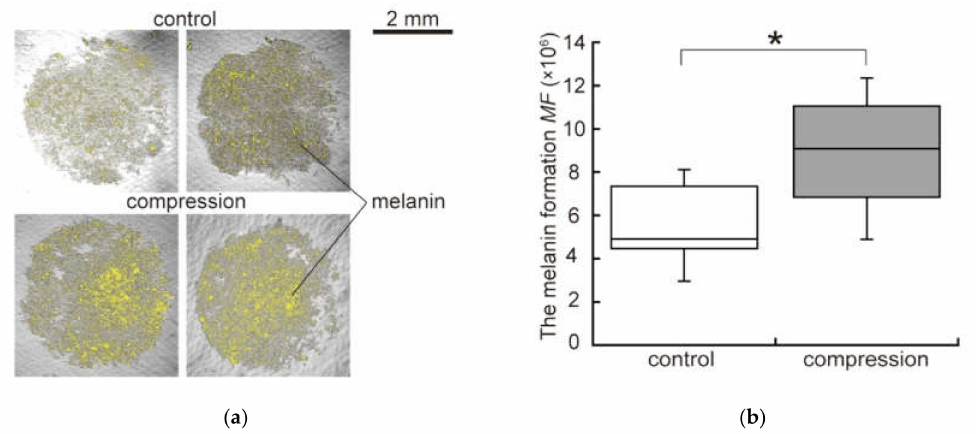
Figure 5. The di ff erence of melanin synthesis in the malignant melanoma model: ( a ) Distribution of synthesized melanin in both groups at 32 h of culture. Yellow color in the images indicates the concentrated melanin; ( b ) The melanin formation ( MF ) at 32 h (n = 5). Experimental data were examined for significant di ff erences using Student’s t -tests. * indicates a significant di ff erence compared to control group ( p < 0.05).